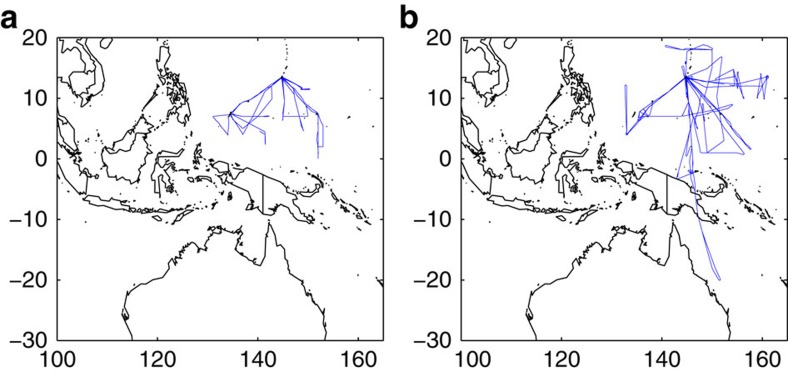
Flight tracks for the CAST and CONTRAST campaigns.Tracks for (a) CAST and (b) CONTRAST flights analysed in this study.